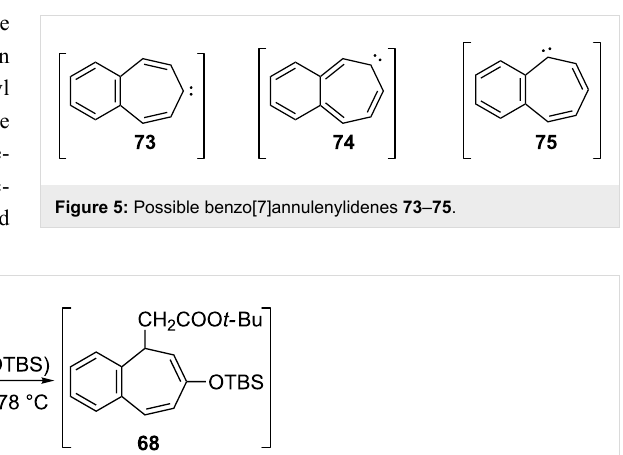
TBS-enol ether intermediate 68 was first formed by the Mukaiyama–Michael reaction of O -silyl ketene acetal to 4,5- benzotropone ( 11 ) at low temperature in the presence of catalyt-